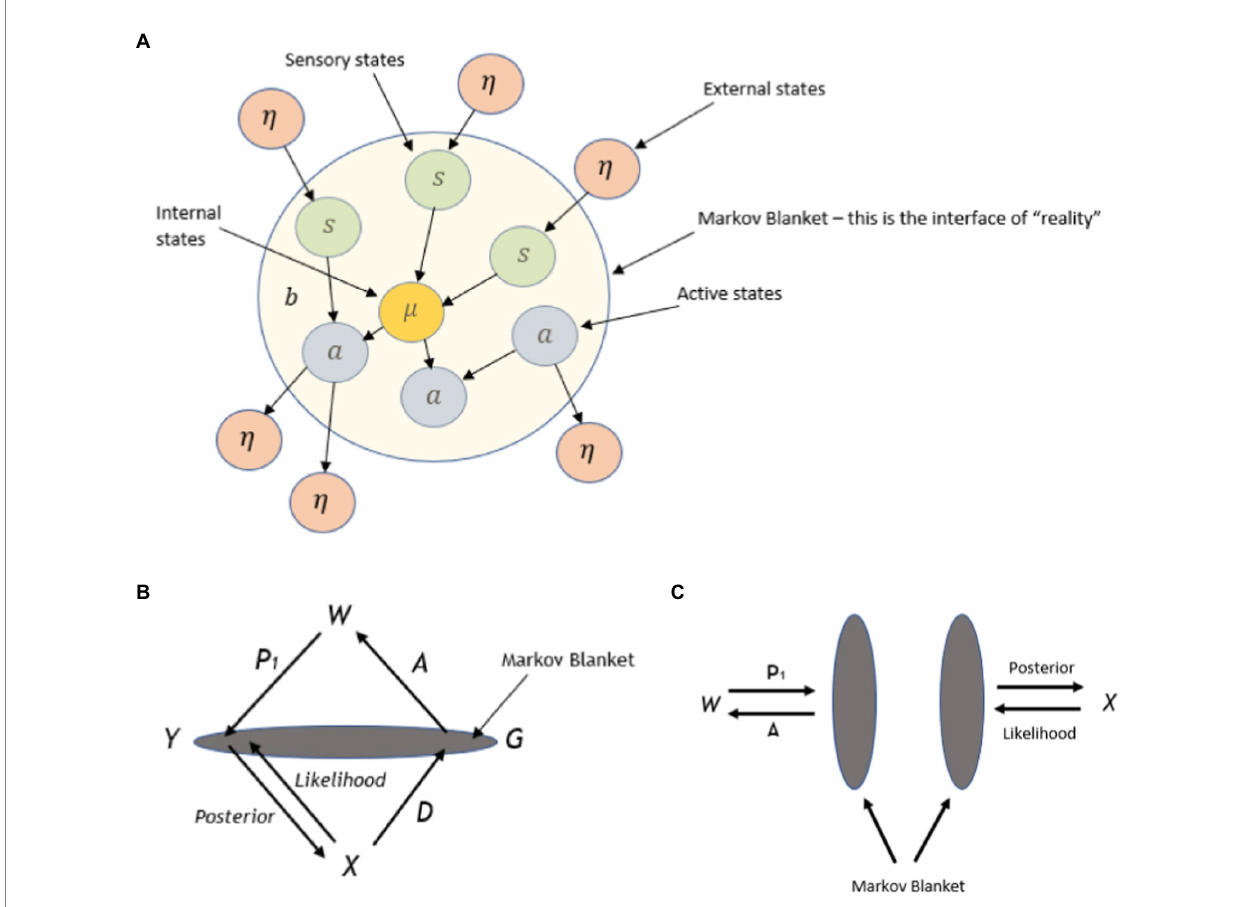
FIGURE 12 (A) A Markov blanket b that highlights the exchange of information with its surroundings whereby external states (variables) η are conditionally independent of internal states μ . Note: Markov blanket = b ; η = external states; μ = internal states; s = sensory states; a = active states. (B) P in a CA framework with a Markov blanket, with P 2 in the CEP formalism, produces a four-node graph, replacing the three-node graph of the typical CA (Figure 9). Bidirectional indirect interaction between W and X via their proximal surfaces is demonstrated in B and C [Reprinted with permission from Elsevier (Fields et al.,